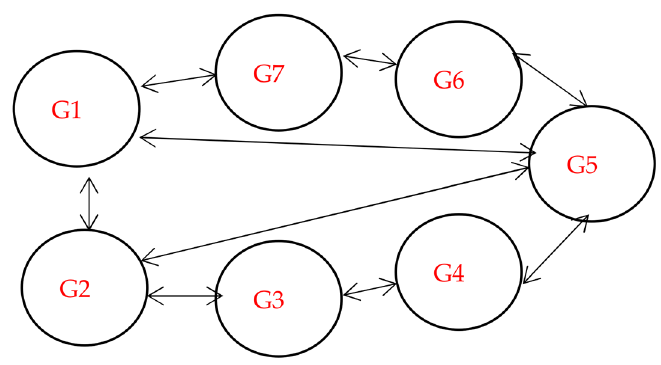
Figure 1. Proposed model for data replication in fog